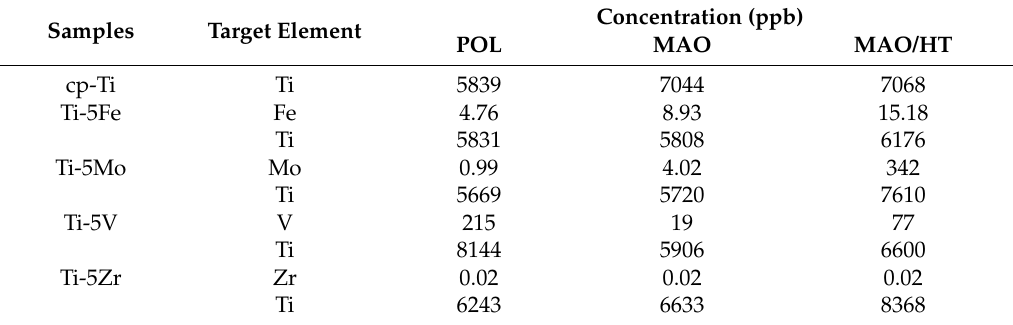
Table 5. Inductively coupled plasma mass spectrometry (ICP-MS) analysis results for lysate of POL-, MAO-, and MAO/HT-treated samples extracted in phosphate-buffered saline (PBS) solution at 37 ˝ C for 3